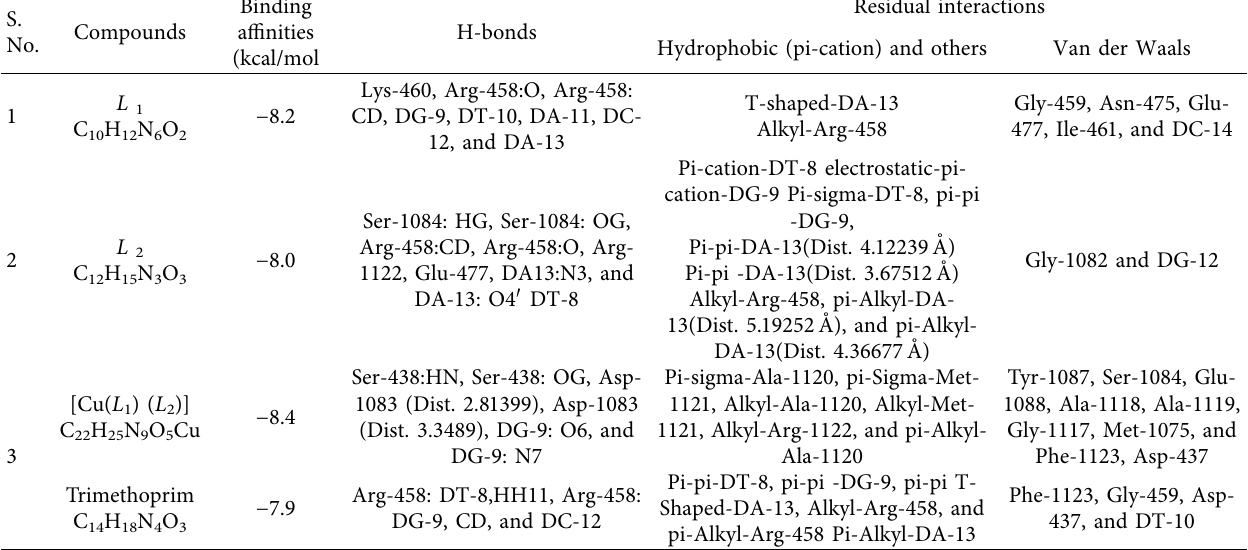
Table 4: The docking results of the samples on bacterial enzyme.